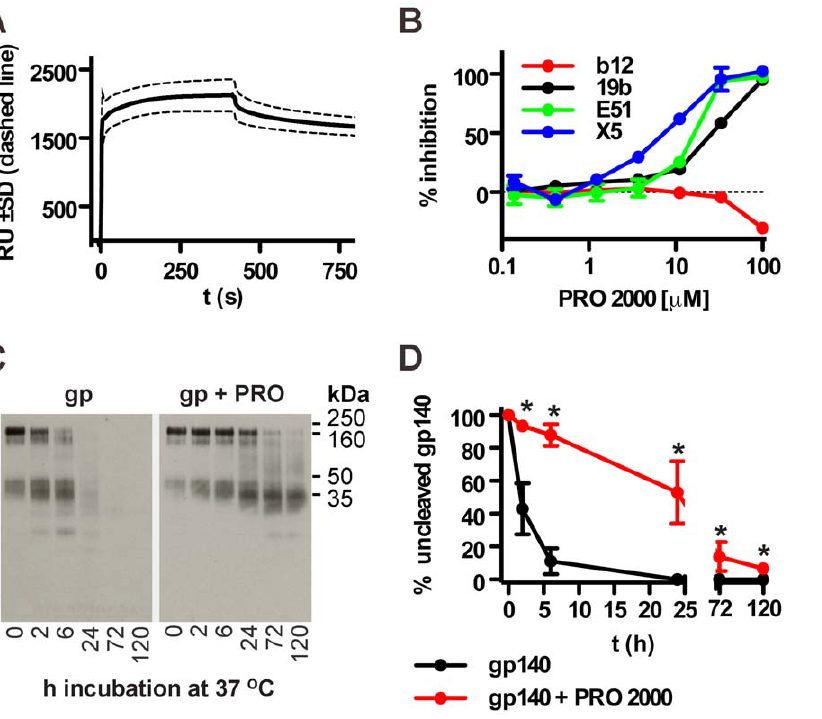
Figure 7. PRO 2000 binds the gp140 CN54 coreceptor binding site and protects against vaginal lavage-mediated degradation. ( A ) gp140 CN54 and the control protein BSA were immobilized on a CM5 sensor chip and 100 m M PRO 2000 was flowed over the chip. The mean curve (solid line) 6 SD (dashed line) of three independent experiments is shown. ( B ) Competition of PRO 2000 with mAb-binding (mAbs used at 50% binding concentration) was determined by ELISA using immobilized gp140 CN54 ; Means of triplicates 6 SD are shown. ( C ) Western blot of gp140 CN54 in human vaginal lavage incubated either alone or in the presence of 100 m M PRO 2000 at 37 u C for the indicated periods of time. Uncleaved gp140 shows an apparent mol wt of 160 kDa. ( D ) Quantification of four independent stability experiments 6 SD. * p , 0.05.